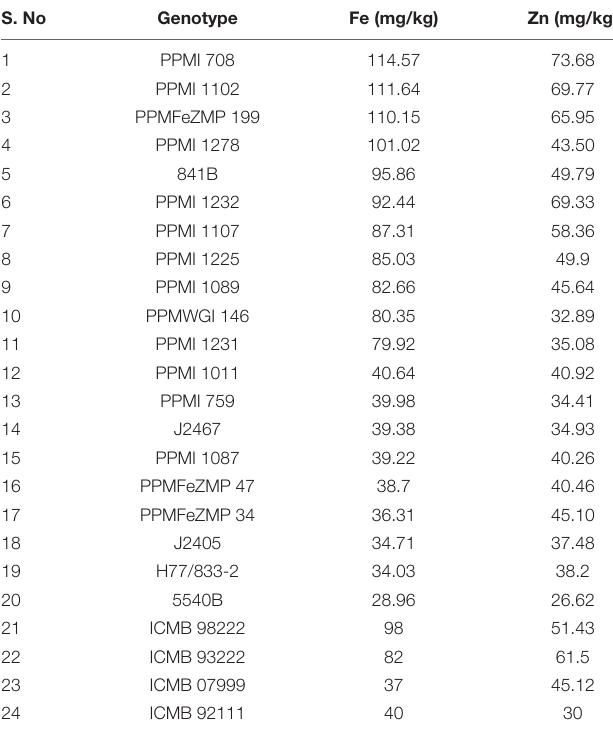
TABLE 9 | List of pearl millet genotypes used to validate the flanked markers of QTLs for grain iron and zinc content. S. No Genotype